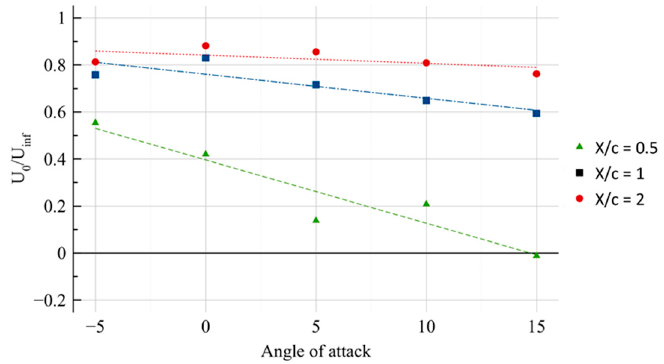
Figure 15. Time-averaged axial velocity in the center of the vortex ( U 0 ) at the three measurement levels, without winglet.